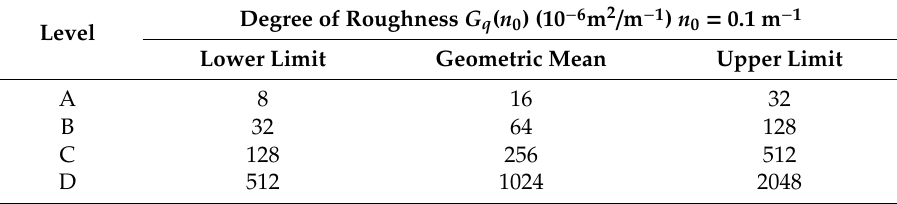
Table 1. Classification standard of road levels A–D.